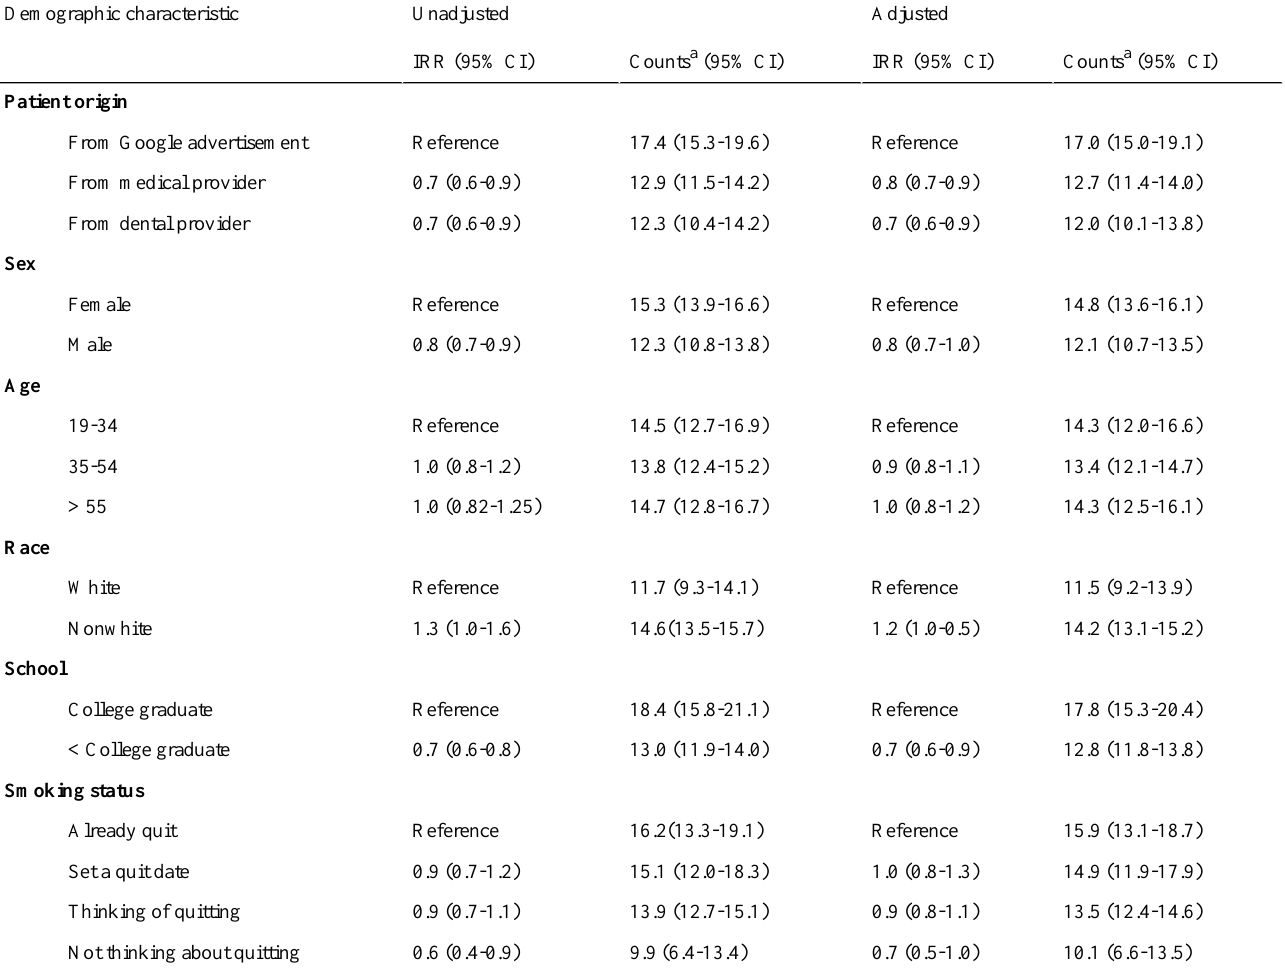
Table 3. Associations between recruitment source and use of Decide2Quit.org. AdjustedUnadjustedDemographic